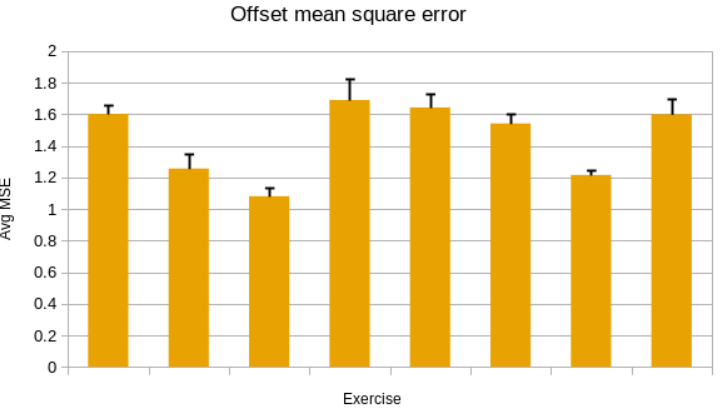
Figure 10. Skeleton inverse kinematics Offset MSE by exercise. The achieved skeleton inverse kinematics joint MSE was stable accross the whole averaged video-frame sequence as is displayed in Figure 11.